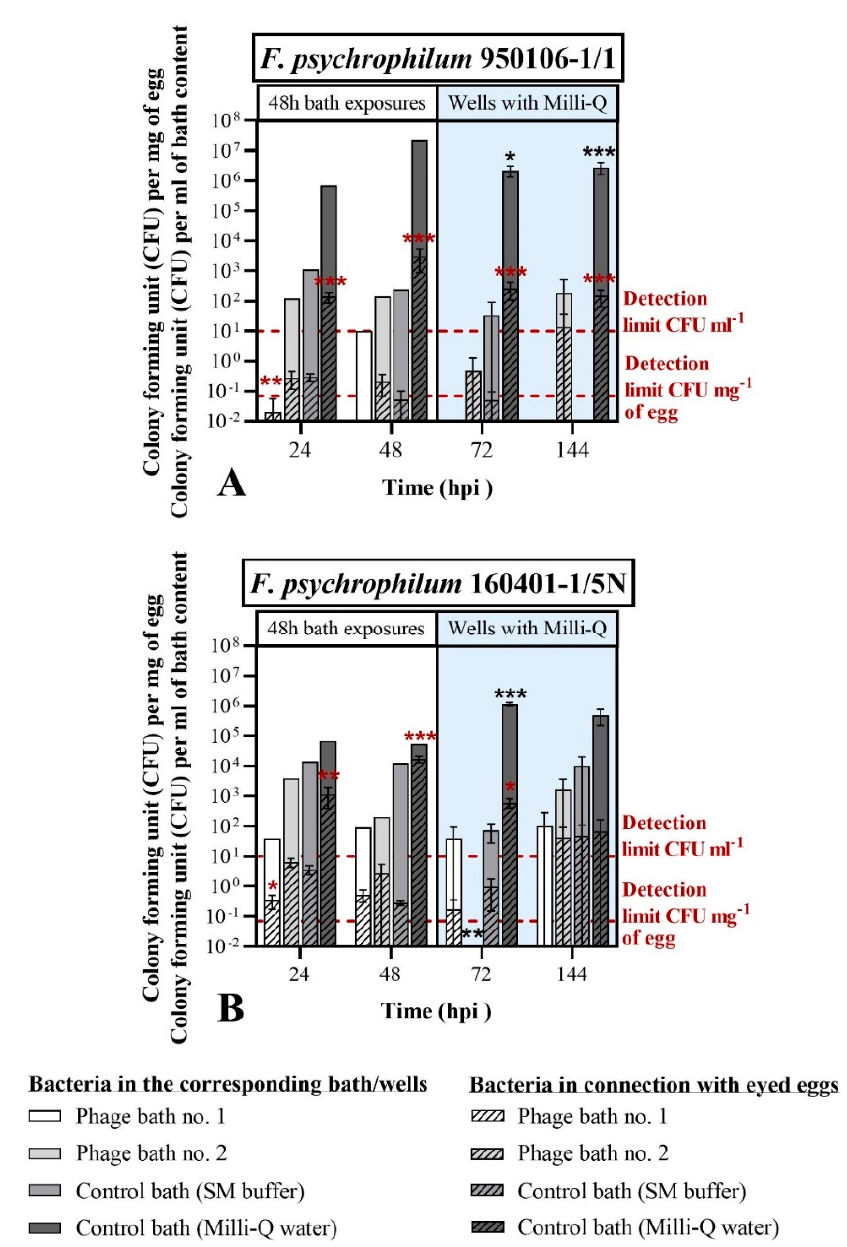
Figure 6. Exp. I, section C: F. psychrophilum 950106-1/1 ( A ) and F. psychrophilum 160401-1/5N ( B ) in connection with the eyed eggs and in the corresponding bath/well. After the bacterial challenge, eyed eggs were bath-exposed to phages FpV4 and FPSV-D22 mixed 1:1 (phage bath no. 1: 10 9 PFU mL − 1 ; phage bath no. 2: 10 8 PFU mL − 1 ; or control baths containing either SM buffer or Milli-Q water) for 48 h and subsequently moved to 24-well sterile plates containing sterile Milli-Q water (in light blue). Values represent the mean and standard deviation of three biological replicates except for the bath content at 24 and 48 hpi ( n = 1). In the control group for bacterial infection (control bath with TYES-B), F. psychrophilum was not detected in eyed eggs and in the corresponding bath/wells. For the concentration of bacteria, the detection limit is indicated by red broken lines (calculated as 1 CFU was observed in the undiluted egg (mean weight = 100 mg) or well sample). Unpaired t tests of log-transformed values were performed to compare the tested conditions (phage baths and Milli-Q water-control bath) with the SM buffer-control bath. Statistically significant comparisons are visualized on top of each column (red: eyed egg values; black: well values) as follows: p < 0.05 (*), p < 0.001 (**), p = 0.0001 (***).